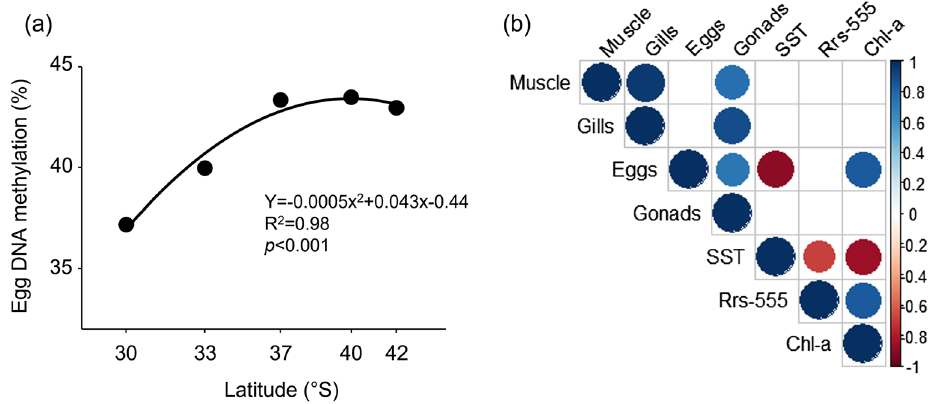
Figure 3. Results of OLS regression between Egg methylation levels and Latitude ( a ) and correlogram ( b ) showing the most correlated variables (Spearman correlations) among the DNA methylation levels (muscle, gonad, gills and eggs) and the climatologies (SST, Rrs(555), and Chl-a). Circles represent significant correlations ( p < 0.05) between variables, while the absence of a circle (blank cells) represents a non-significant correlation. The size and the colour of the circles in the correlogram represent the correlation coefficient (R) reported in the legend on the right side of the correlogram (− 1 < p > 1).